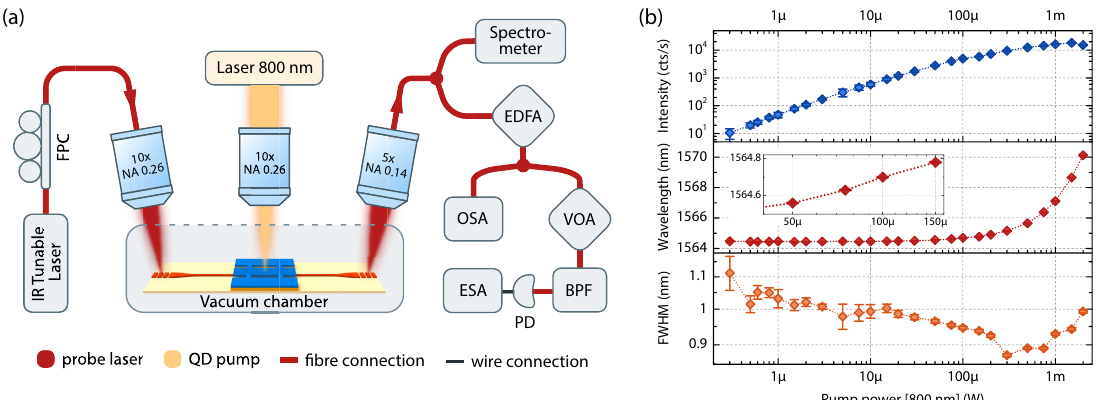
Figure 2. ( a ) Schematic of the experimental set-up for the characterization of optical/optomechanical transduction of non-resonant pump ( λ pump = 800 nm) to resonant probe ( λ probe ≈ 1.56 µ m); ( b ) Emission properties of the QDs, filtered by the L 3 cavity (loaded λ c = 1564.5 nm): fitted intensity I , wavelength λ 0 and linewidth κ of the collected emission are plotted versus non-resonant pump power. Inset: zoom-in of λ 0 power